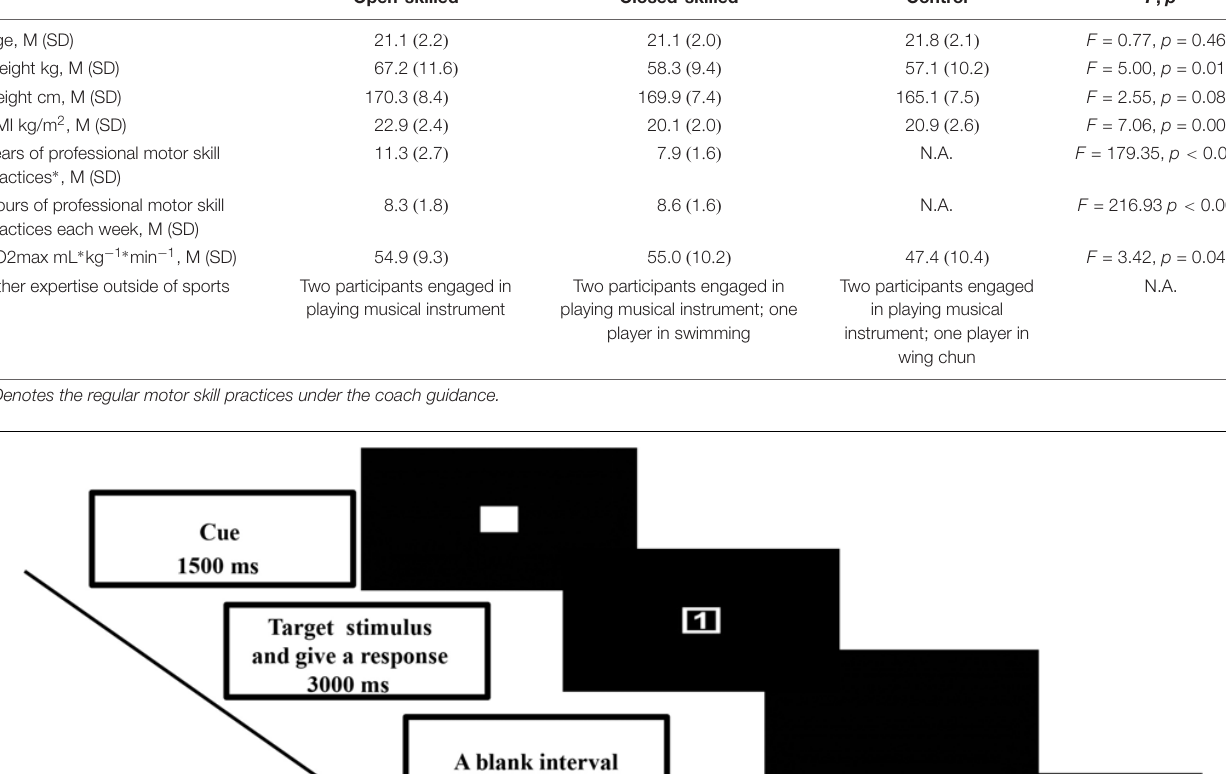
TABLE 1 | Demographic characteristics of the open-skilled, closed-skilled and control participants. Open-skilled Closed-skilled Control